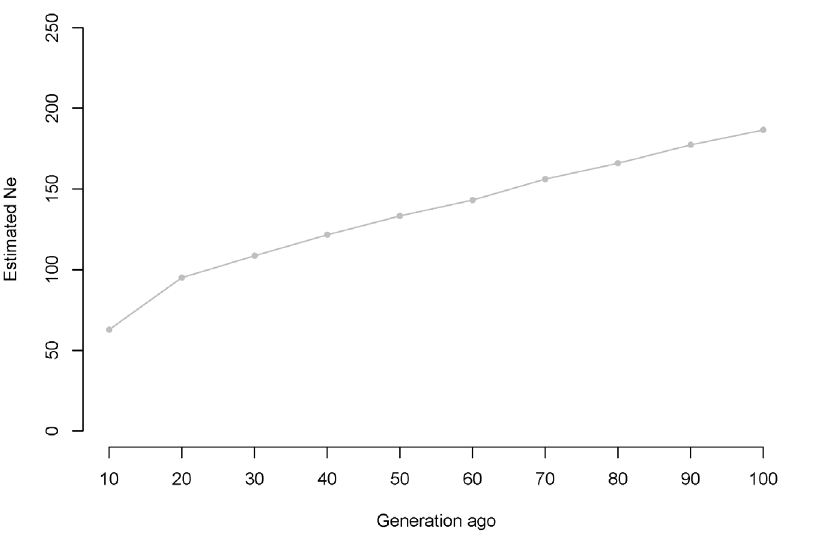
Figure 5. Average estimated Ne versus previous generations, truncated at 100,000 generations using r 2 . The estimated Ne and previous generations are plotted on a log